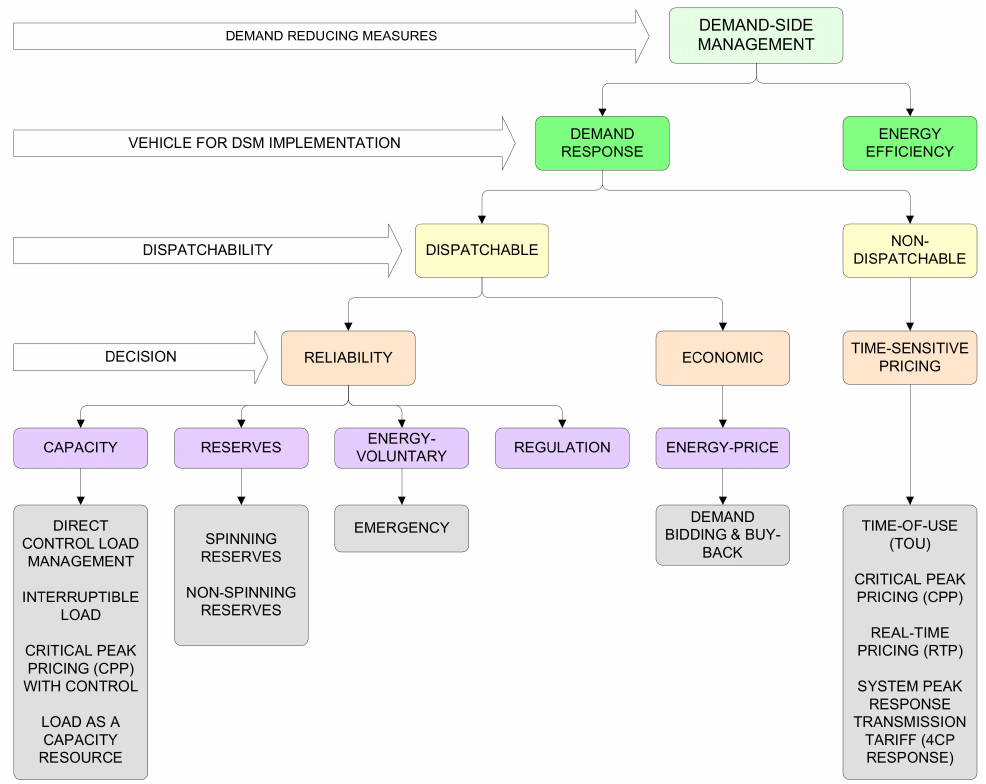
Figure 1. Demand-response categories